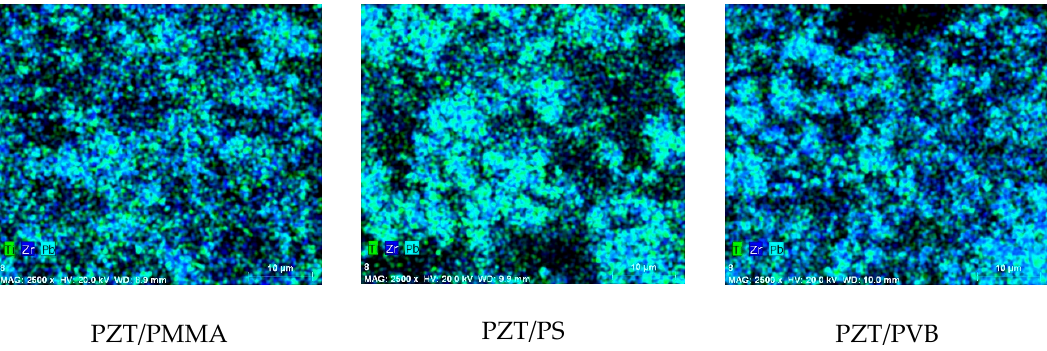
Figure 6. Elemental mapping done with SEM of the samples with different binders mixed with PZT.